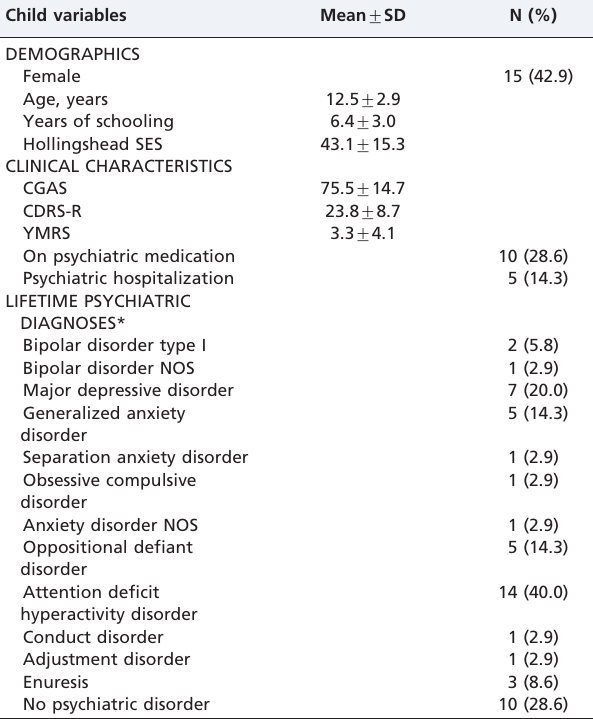
Table 1 - Demographics, clinical characteristics, and lifetime psychiatric diagnoses of the offspring (N=